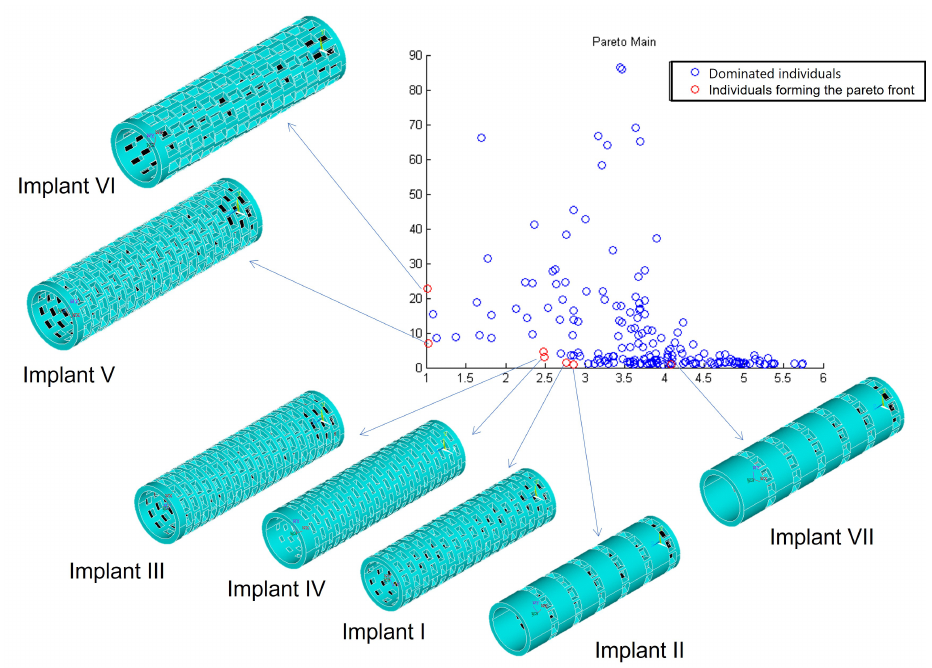
Figure 16. Geometric features of Pareto-optimal individuals.